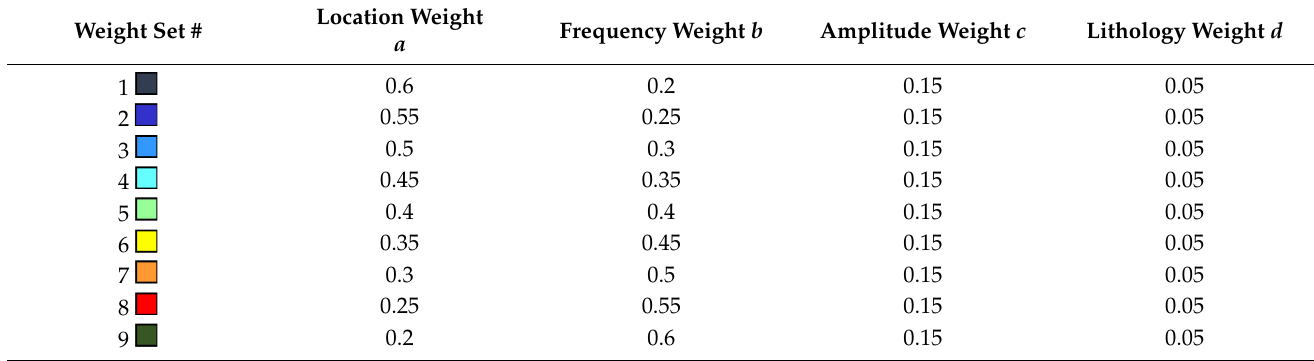
Table 1. Weight sets used to calculate the Euclidean